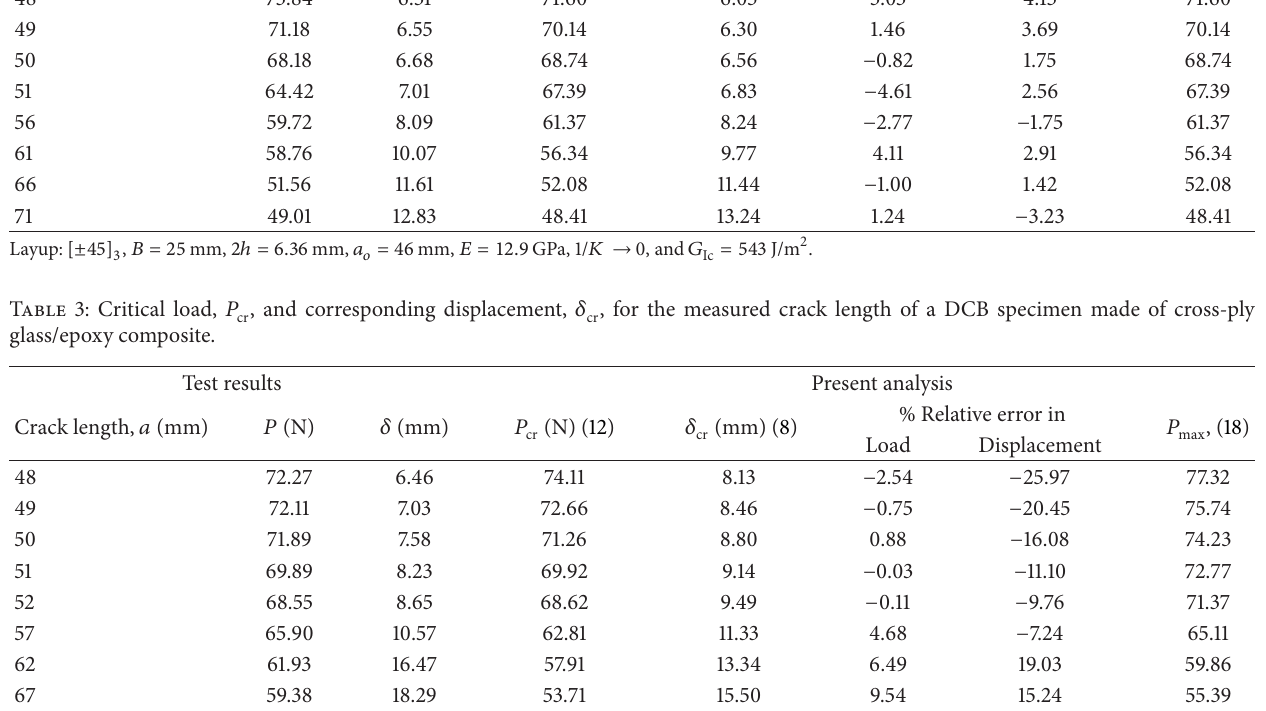
, for the measured crack length of a DCB specimen made of angle ply cr